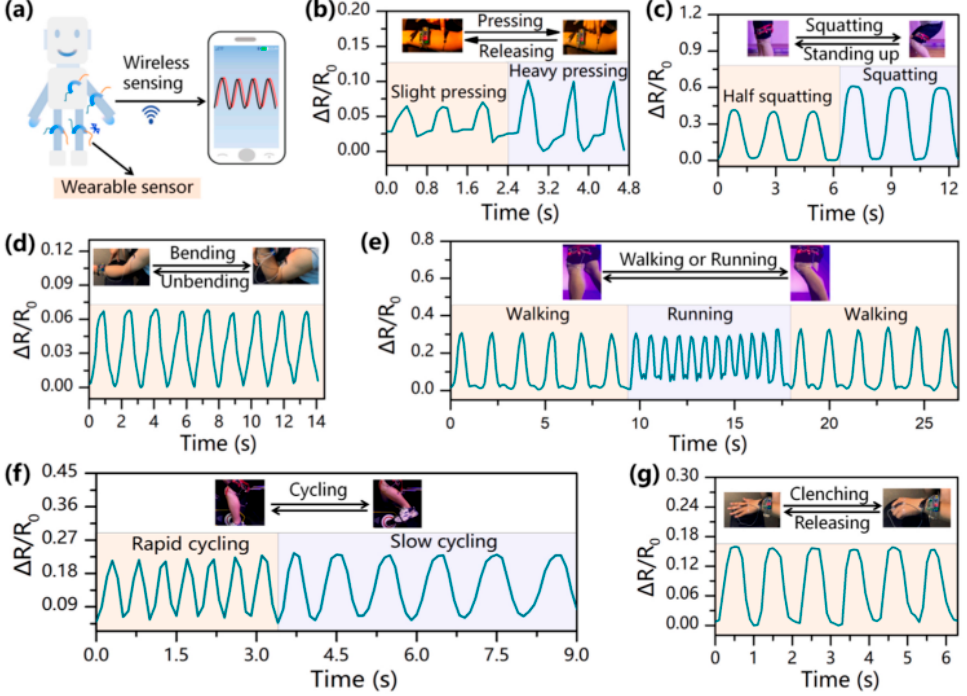
Figure 11. ( a ) Illustration of wearable sensor for wireless sensing. PNIPAM-ECH for ( b ) pressing-releasing detection. ( c ) squatting-standing up detection. ( d ) finger bending-unbending detection. ( e ) walking or running detection. ( f ) rapid cycling and slow cycling detection. ( g ) clenching and releasing detection. Copyright from Ref. [74] Elsevier.